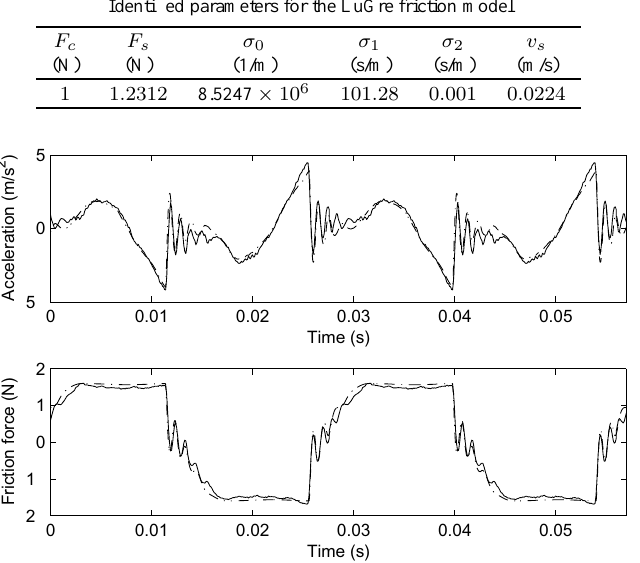
Fig. 12. Time history of the acceleration and the friction force for the set-up with the Br¨uel and Kjaer 4809 shaker with F ex = 1 . 75 N, ω = 35 Hz and γ N = 1 . 297 N. Experimental time history ( −− ) and simulated time history ( ·−· ).